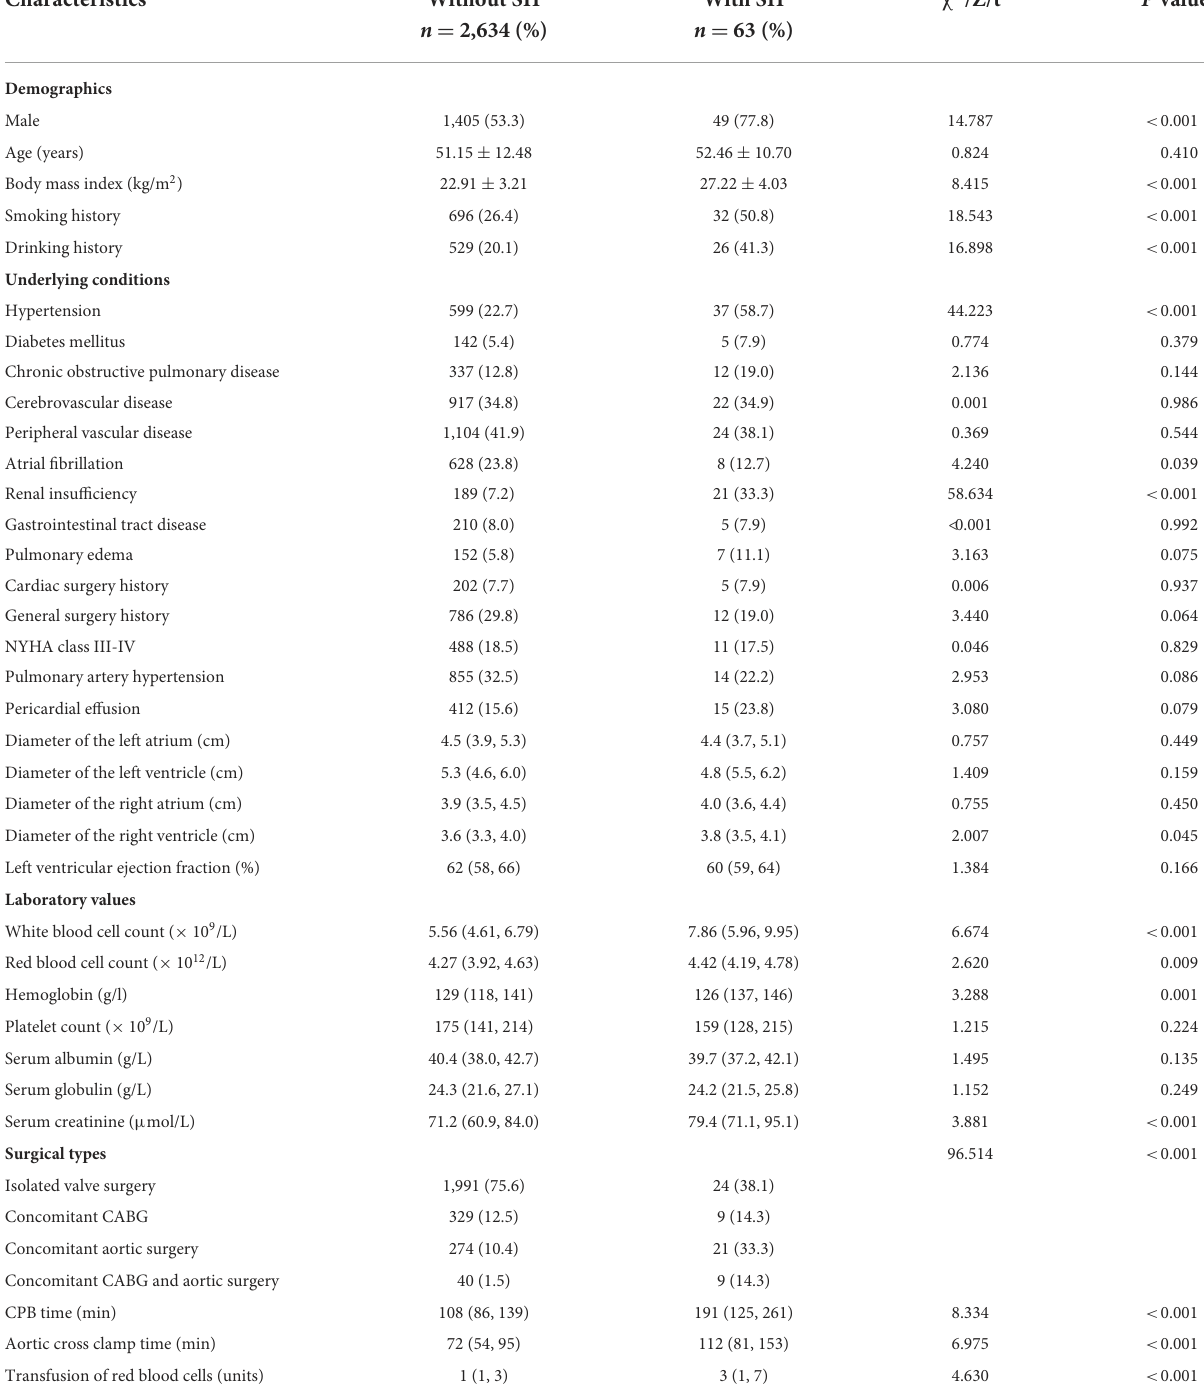
TABLE 1 Univariate analysis of possible risk factors for SH following HVS in the training set.